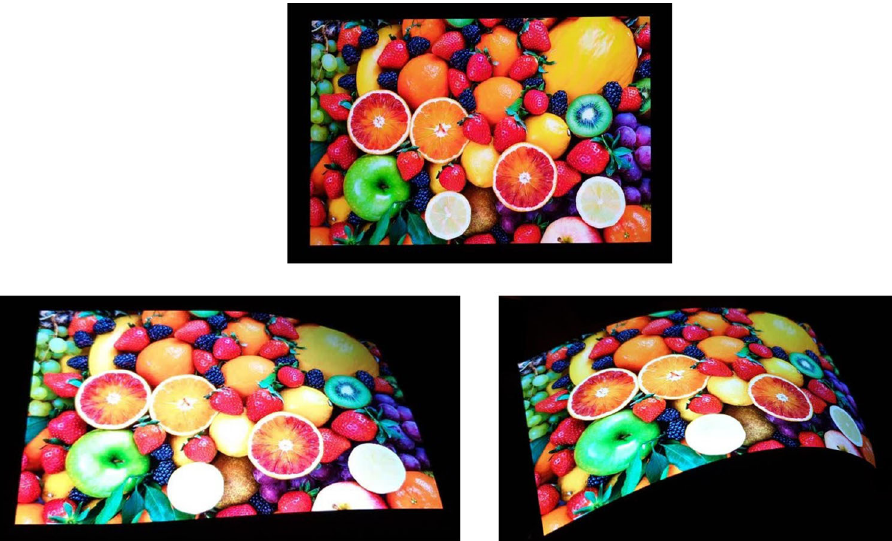
Fig. 6 Panel driving characteristics. Driving test of fl exible OLED display with the PI-Al 2 O 3 hybrid barrier nanolayer via ALI technology (Image from www.shutterstock.com).